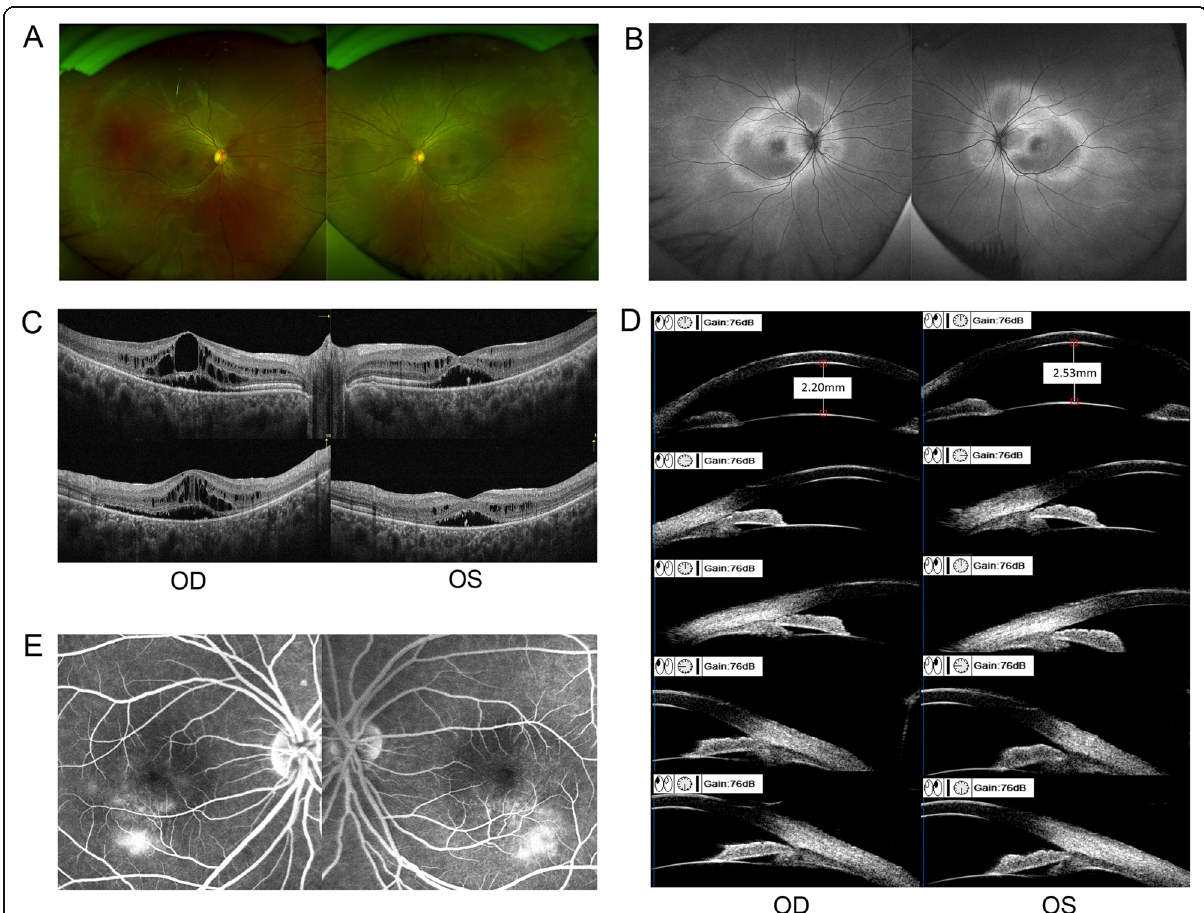
Fig. 1 Clinical features of the ARB patients in the family. a Color funduscopy (CF) of the proband was normal, overall. b Fundus autofluorescence (FAF) image of the proband showed annular hyperfluorescence around the posterior pole. c OCT results of the proband revealed bilateral cystoid macular edema with subretinal fluid. d The affected younger sister ’ s ultrasound biomicroscopy (UBM) results showed a shallower anterior chamber depth, and half of the anterior chamber angles were closed. e The affected younger sister ’ s fundus fluorescence angiography (FFA) revealed mild fluorescence leakage beneath the